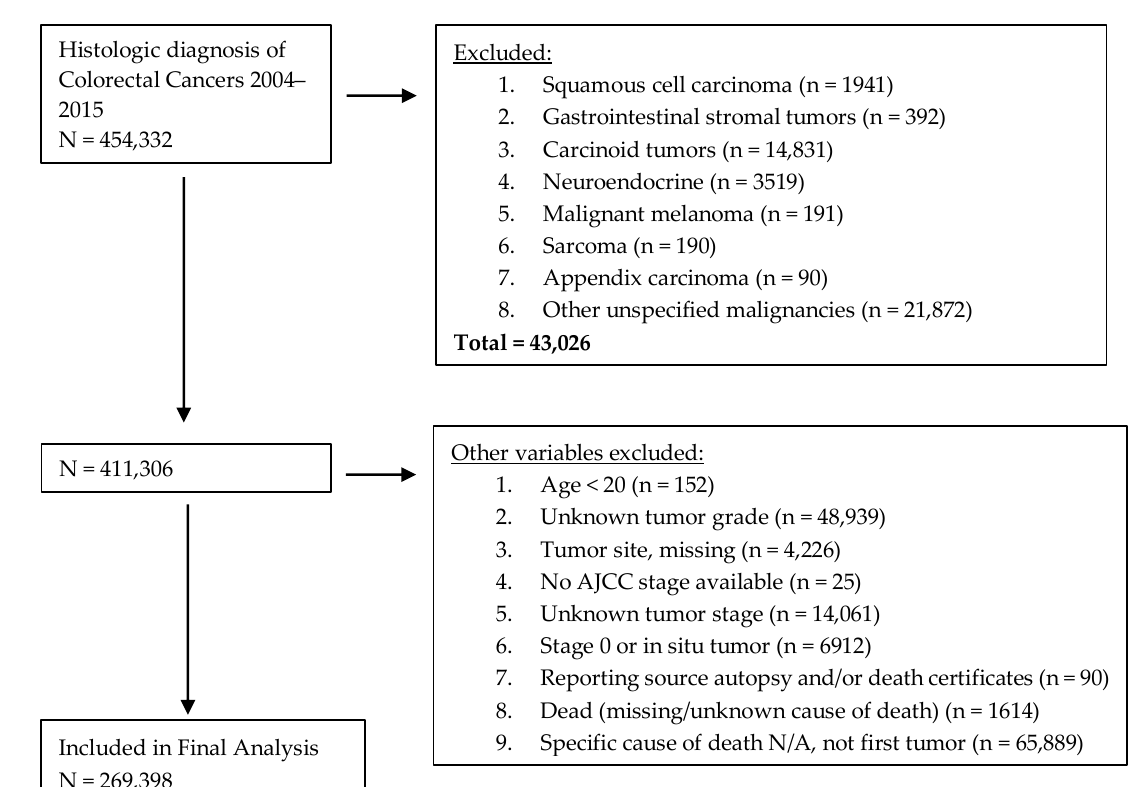
Figure 7. Patients’ cohort flow chart showing exclusion criteria.